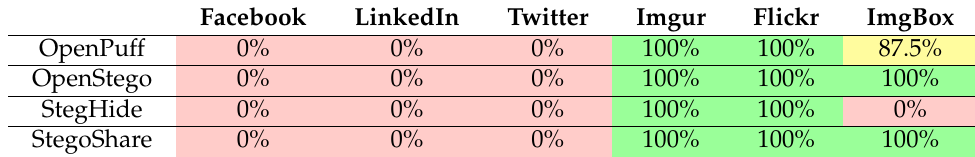
Table 4. Percentage of successfully retrieved messages.